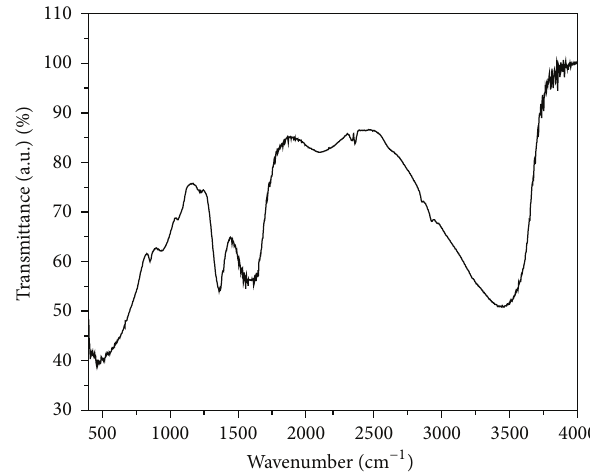
Figure1:FTIRspectraofZrO 2 ofNPsinthe400–4000cm −1